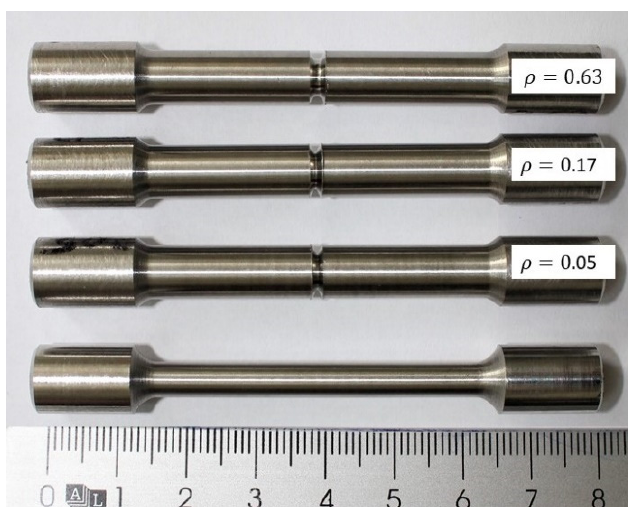
Figure 4. Machined smooth and notched tensile test pieces with different notch root radii.